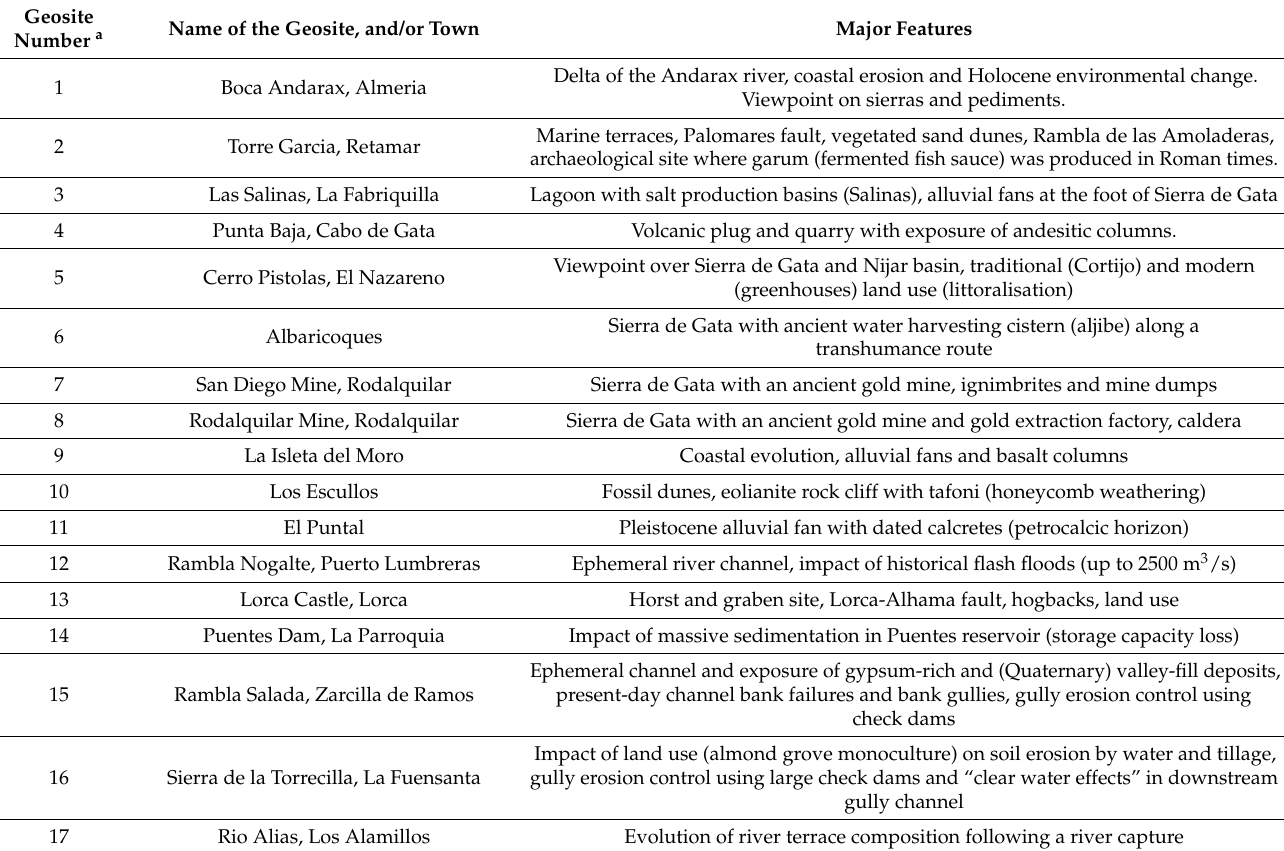
Table A1. Description of the geosites in southeastern Spain. For their location, see Figure 1b; for their scenic beauty rating, see Table A3 in Appendix A; for their photos, see Questionnaire S1 in the Supplementary Materials. Geosite Number